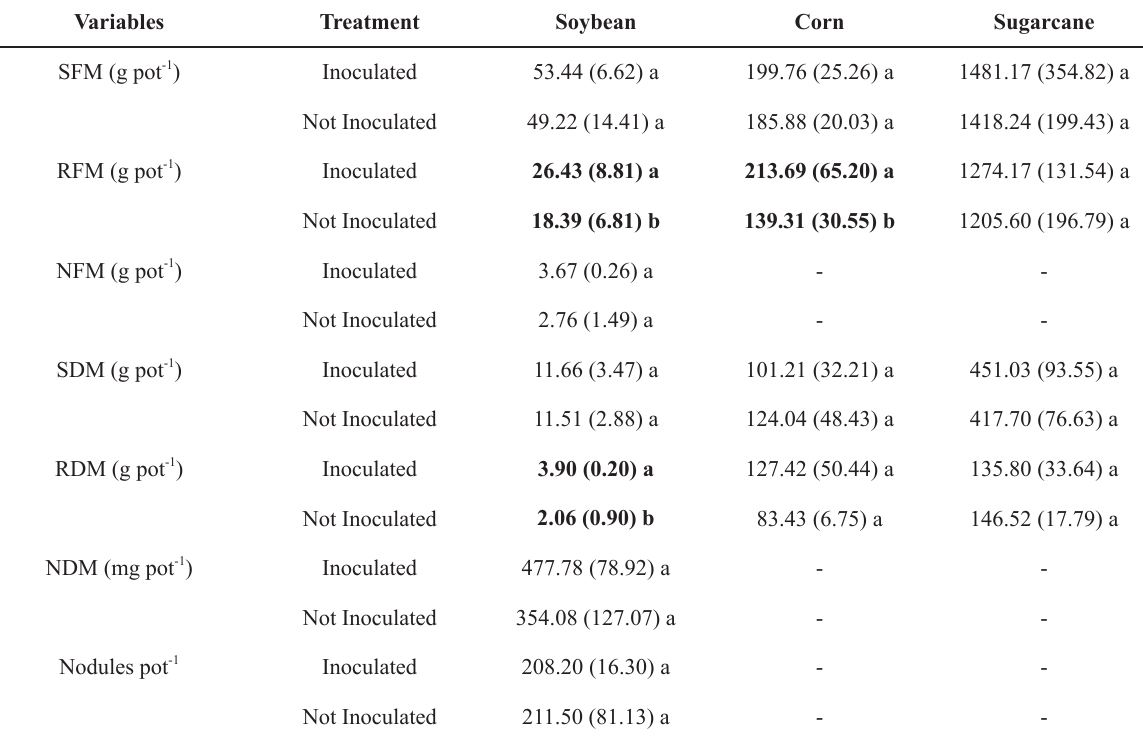
Growth variables of soybean, corn, and sugarcane inoculated and uninoculated with the fungal solution composed of the fungi Beauveria bassiana, Metarhizium anisopliae, Pochonia chalamydosporia, Purpureocillium lilacinum , and Trichoderma asperella